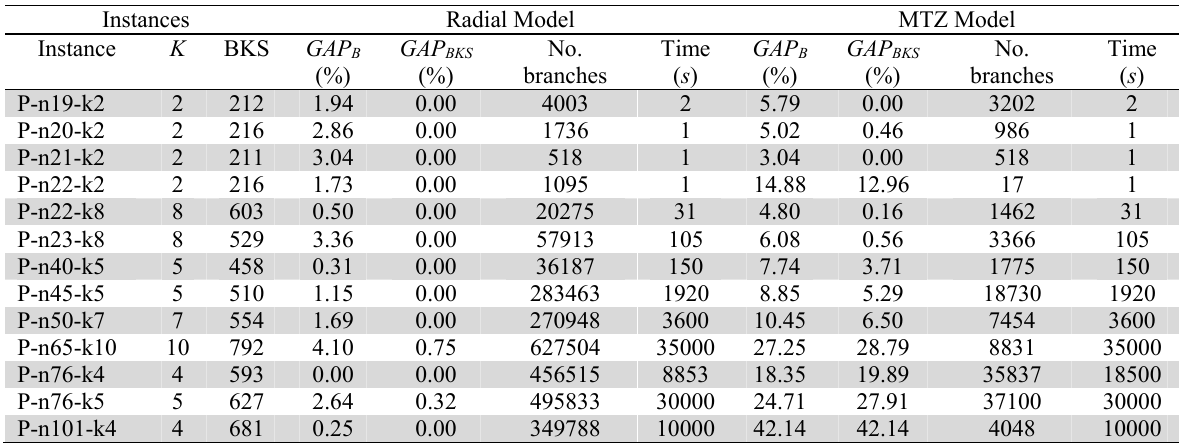
Results for the instances of the CVRP